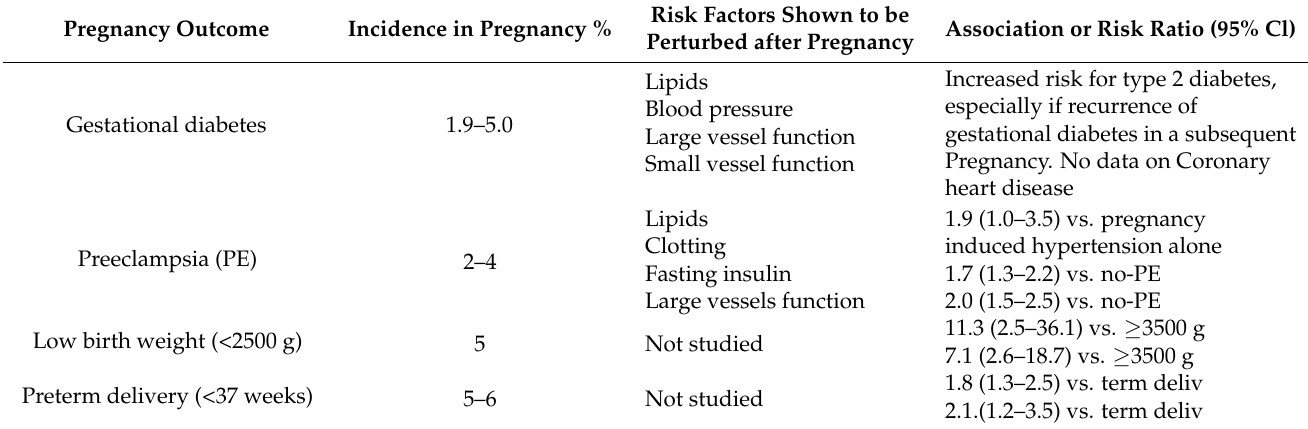
Table 1. Association of adverse pregnancy outcomes with risk of diabetes or risk factors for coronary heart disease and vascular disease. Great Obstetrical syndromes are strictly connected to adverse long-term health consequences. Women with a history of adverse pregnancy outcome appear to be at increased risk of metabolic and vascular diseases in later life. Risk Factors Shown to be Association or Risk Ratio (95% Cl) Pregnancy Outcome Incidence in Pregnancy % Perturbed after Pregnancy